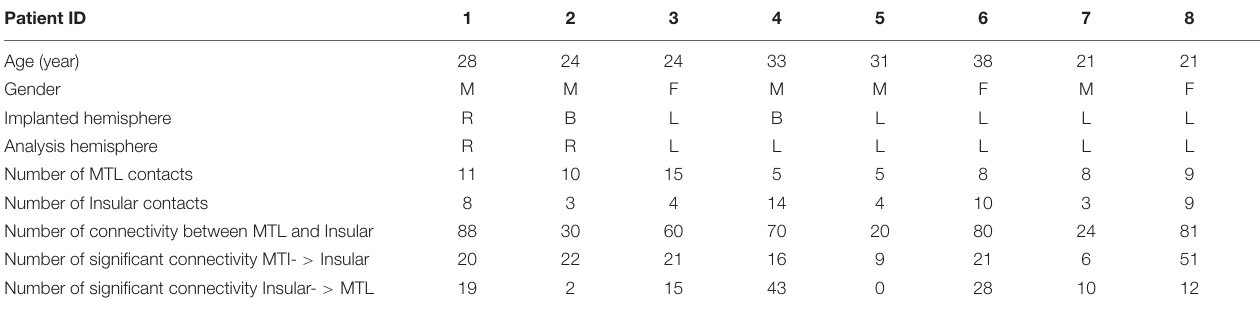
TABLE 1 | Demographic information of patients for MTL-Insular connectivity analysis. Patient